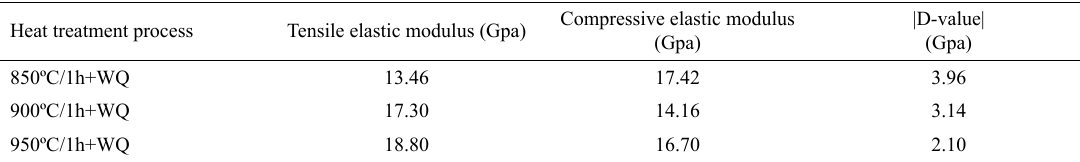
Figure 4. Tensile (a) and compressive (b) properties of Ti-6Al-4V alloy with different heat treatment temperature. Table 5. The tensile and compressive elastic modulus for the polycrystalline material quenched from different